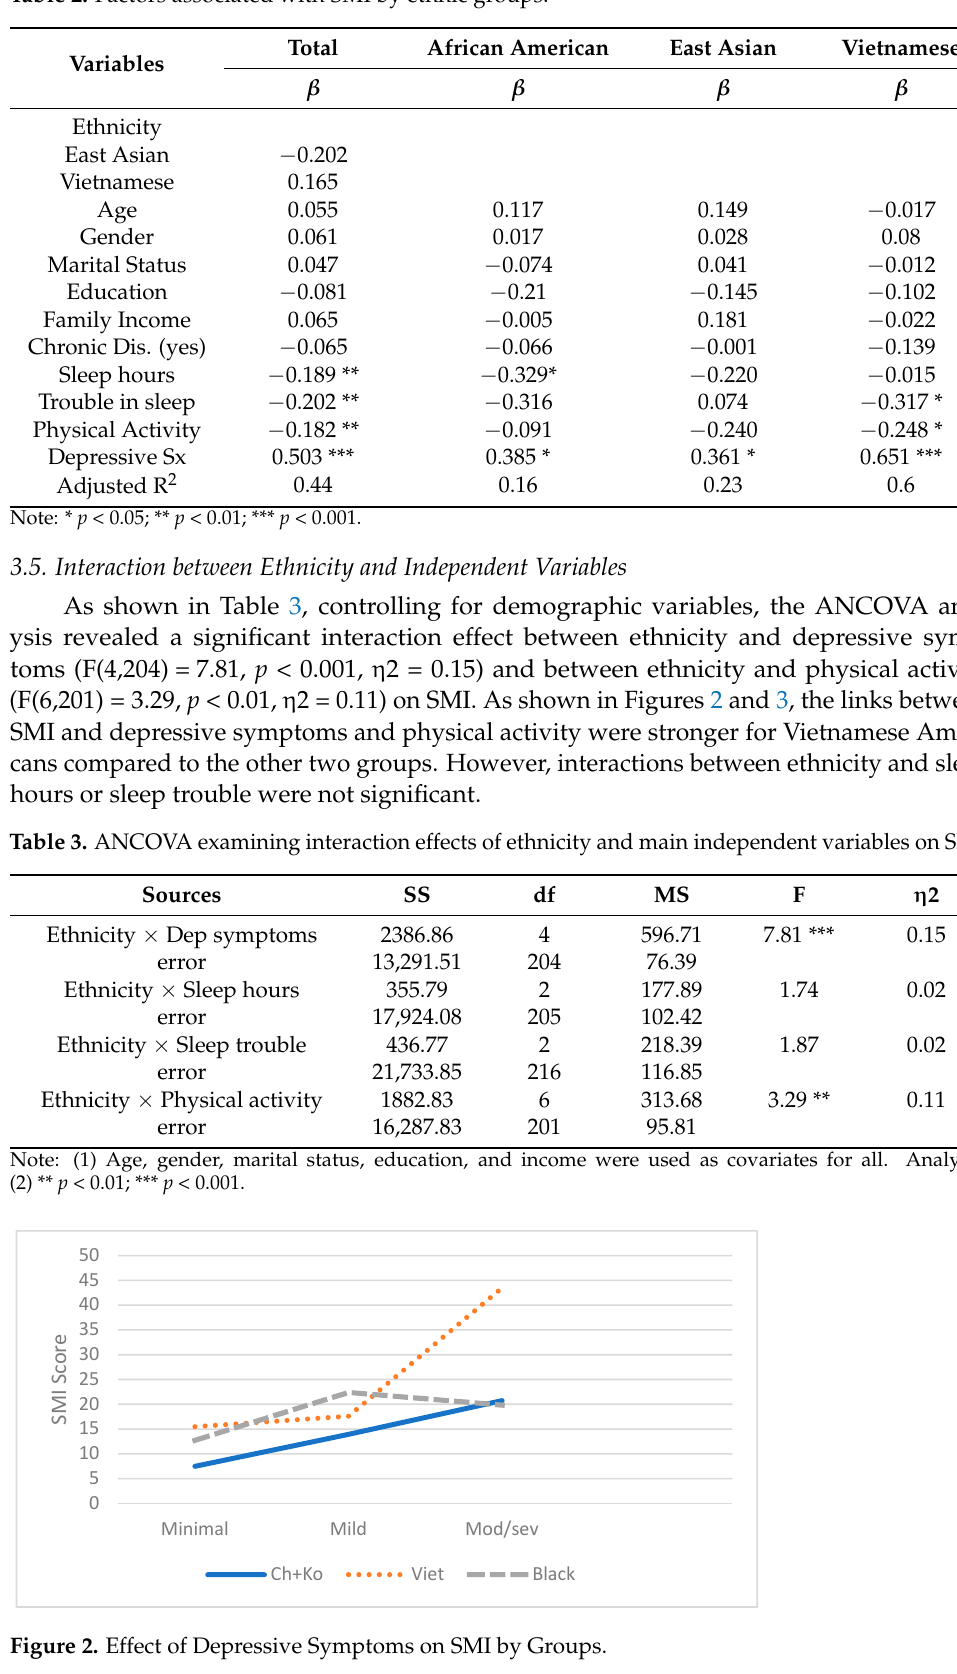
Figure 3. Effect of Physical Activity on SMI by Groups. 4. Discussion This study aimed to contribute to the existing literature regarding subjective memory functioning and factors association with subjective memory functioning among racial and ethnic minority groups in the United States. Our study examined SMI and associated fac- tors across different ethnic groups in the greater Philadelphia area. SMI and risk factors, including depressive symptoms, sleep, and physical activity, were assessed to examine their impact among older African and Asian American subgroups. There are several im- portant findings from this study. Importantly, we found that older Vietnamese adults ex- perienced the highest level of SMI, followed by African Americans. These findings are consistent with previous studies that have demonstrated significant ethnic differences in SMI [22] and subjective memory functioning [66,67]. However, while a previous study reported a higher level of SMI in African Americans compared to Asian Americans [22], our findings revealed that when Asian Americans were examined by subgroups, SMI level was higher in Vietnamese Americans than in African Americans. While research to explain ethnic disparities in SMI is limited, previous investigation of the impact of stressful events and immigration-related stress on subjective memory function among Vietnamese Americans can illuminate our understanding of ethnic dis- parities in SMI. Research has shown that stressful life events, such as traumatic exposure, are linked to poor cognitive function and performance later in life [16,68,69] and acceler- ated cellular aging [70]. Research also suggested that the impact of stressful life events could be notably high among some populations, including those with lower socioeco- nomic status, leading them to experience clinical levels of cognitive impairment earlier in